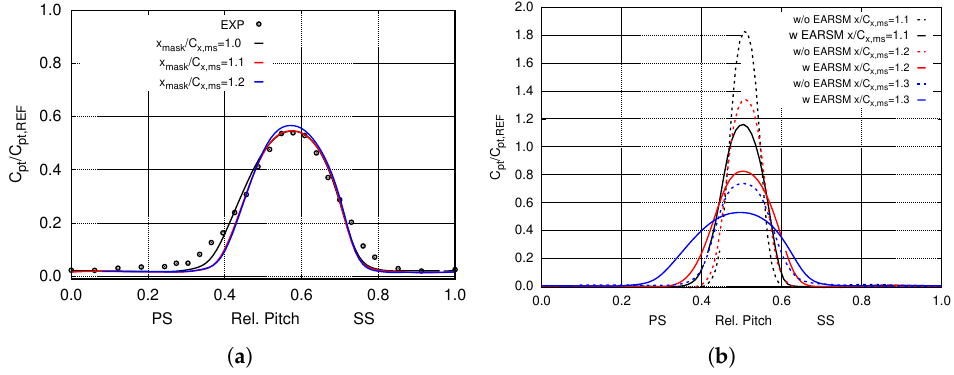
Figure 5. Wake loss profiles at Re 2, is = 0.7 10 5 , ( a ) obtained with different values of x mask (GEP- × EARSM, x / C x , ms = 1.46), ( b ) in different locations downstream of blade TE (GEP-EARSM